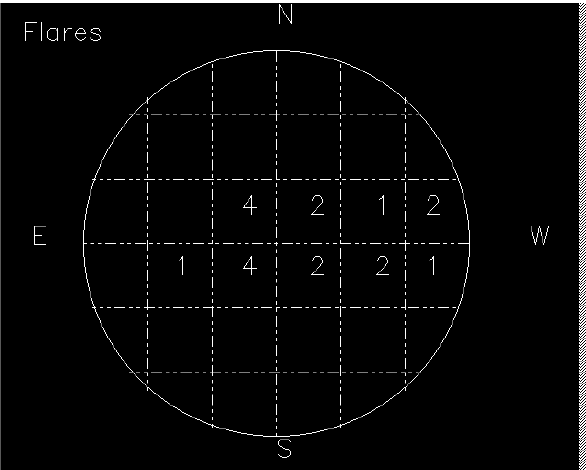
Fig. 11. Positions on the disk of the solar sources of the CMEs chosen in Table 1 (column 7) in the case of association with flares. Lines are drawn every 30 ◦ and numbers of cases in each box are